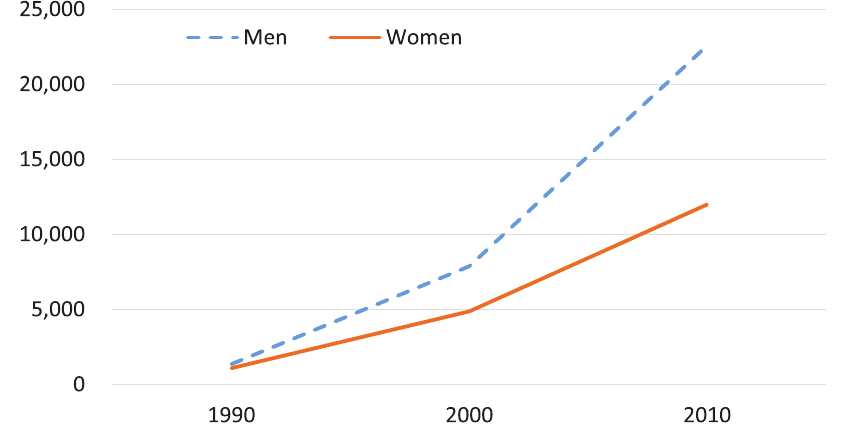
Figure 3. Wage income by gender: China